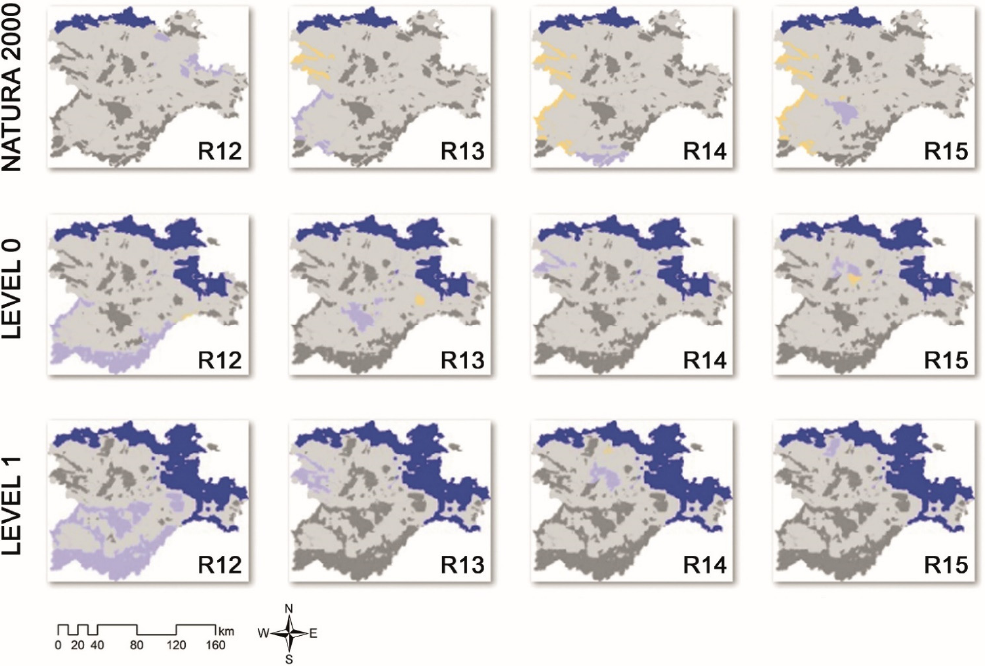
Figure 4. Restoration pathways between the five largest objects for the different scenarios. The starting object is color-coded in dark blue, the target object in lilac, the restoration pathway in red, and intermediate encountered network objects of any size in beige color, where Rxy represents the restoration scenario for the connection of x object with y object.